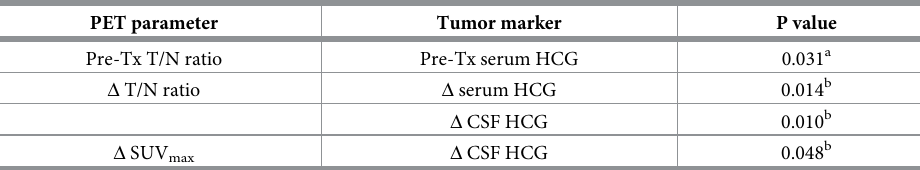
PET, positron emission tomography; pre-Tx, pre-treatment; T/N, tumor-to-normal tissue; HCG, β -human chorionic